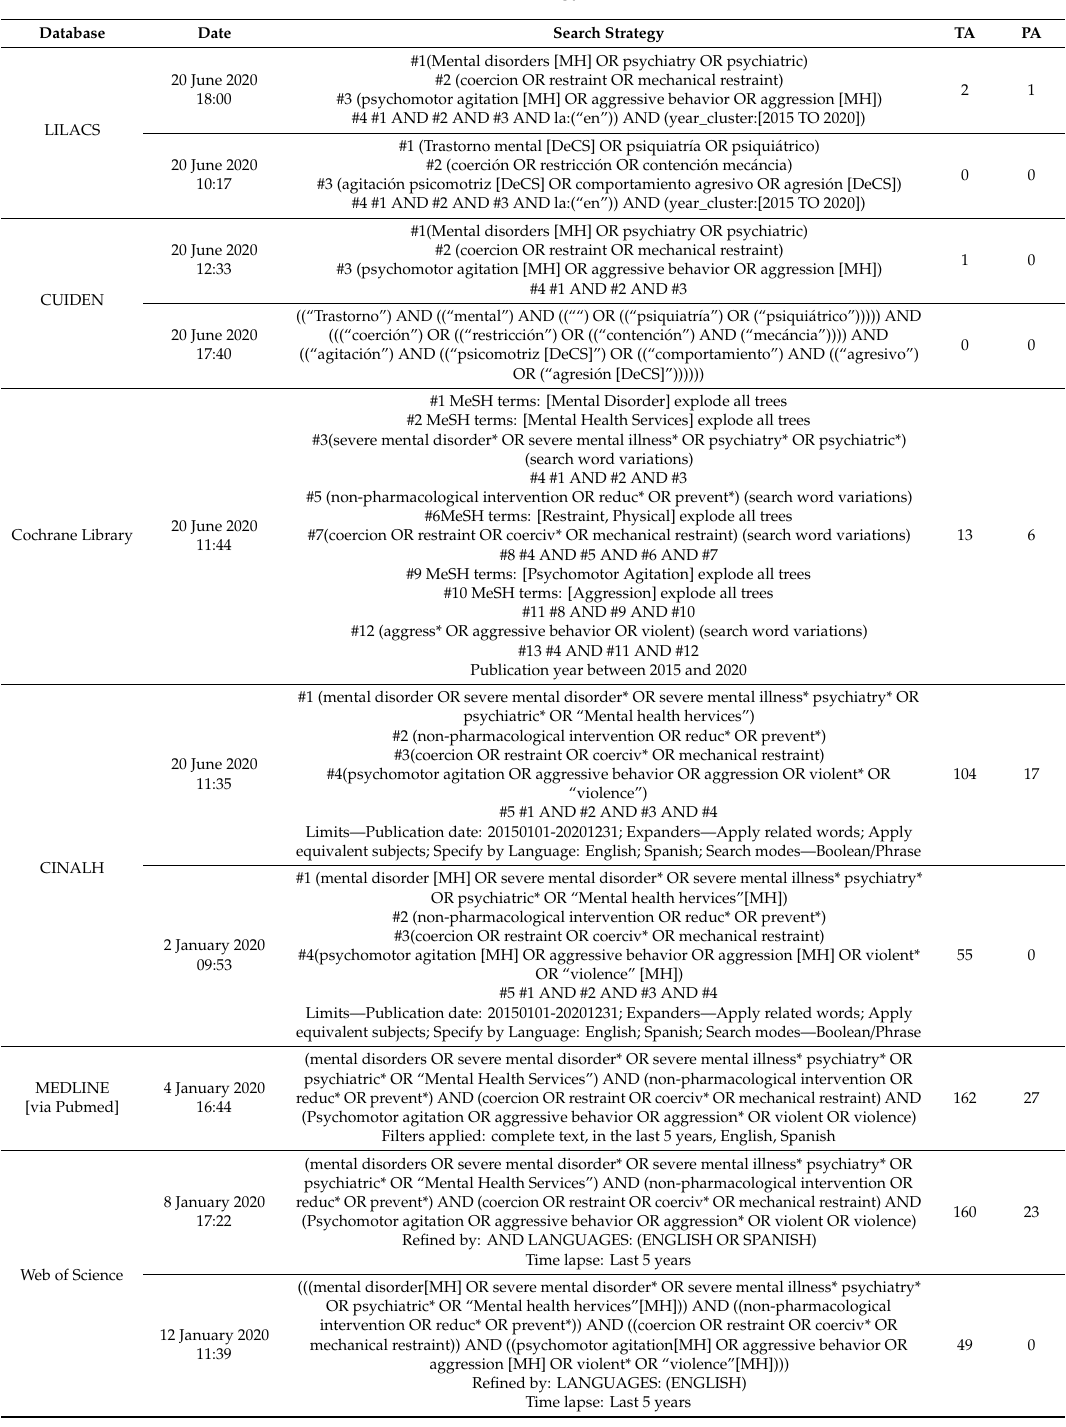
Table 2. Search strategy in